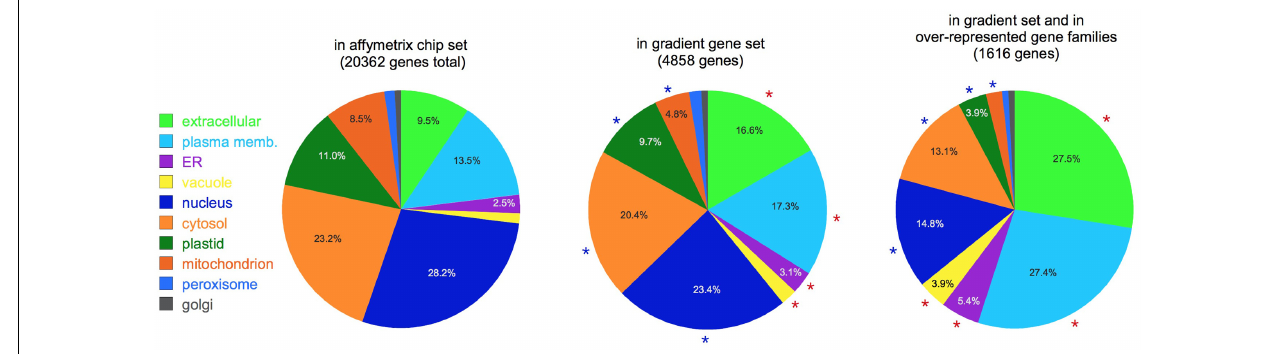
FIGURE 3 | Subcellular localization. Pie charts show the putative localization of genes in the categories shown, as predicted by the SUBAcon algorithm (Hooper et al., 2014). Note the increased prominence of extracellular and plasma membrane localized genes in the gradient gene sets. Red asterisks: categories significantly over-represented compared to the whole Affymetrix set ( p < 0.05); blue asterisks: significantly under-represented ( p < 0.05). For clarity, percentages are not shown for categories with less than 2.5% of the total.